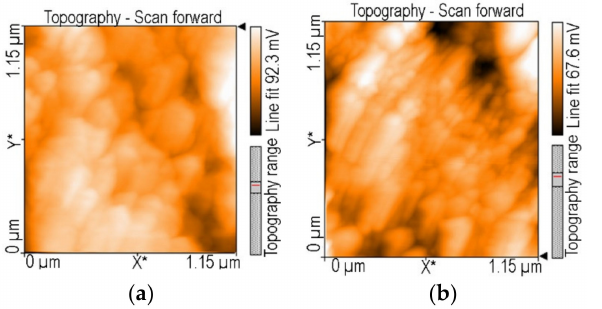
Figure 8. AFM topography images after corrosion tests of the steel electrodes covered with: ( a ) 5- (4-carboxy-phenyl)-10,15,20-tris (4-methyl-phenyl)-porphyrin/MnTa 2 O 6 (h) and ( b ) MnTa 2 O 6 (h), showing that pitting corrosion is absent in ( a ) and is present in ( b